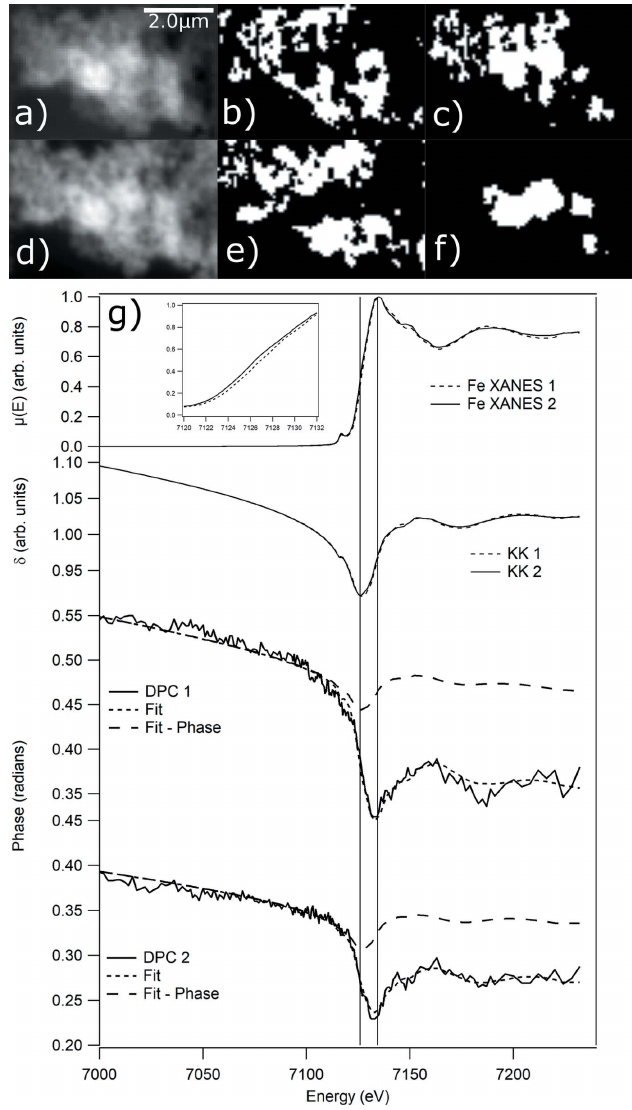
Figure 4 ( a )–( c ) DPC phase image and cluster labels from DPC-XANES signal of a Fe particulate sample. ( d )–( f ) XRF Fe image and cluster labels from XRF-XANES signal clustering. ( g ) (Top) XRF-XANES spectra from the two regions identified by DPC clustering and inset showing edge shift between spectra. (Middle) KK transform of the extracted Fe XRF- XANES. (Bottom) Extracted differential contrast signals from each cluster and linear combination fit of absorption and phase contributions to this signal. The fitted phase components are shown. The peak positions of XRF-XANES and KK transform are shown to demonstrate the peak of the differential signal lies between these two